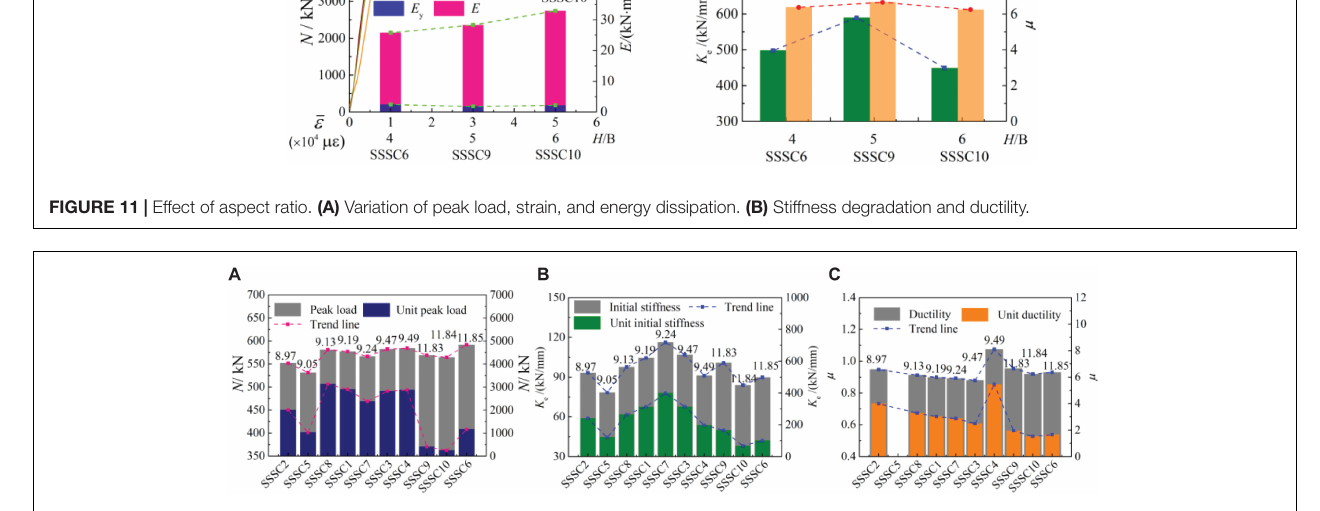
FIGURE 12 | Effect of steel ratio. (A) Bearing capacity. (B) Stiffness. (C) Ductility.